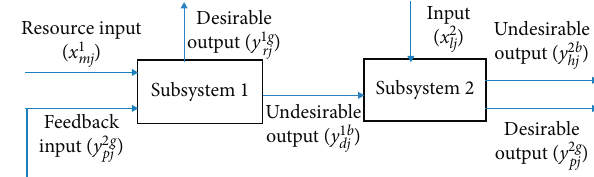
Figure 1: The recycling production